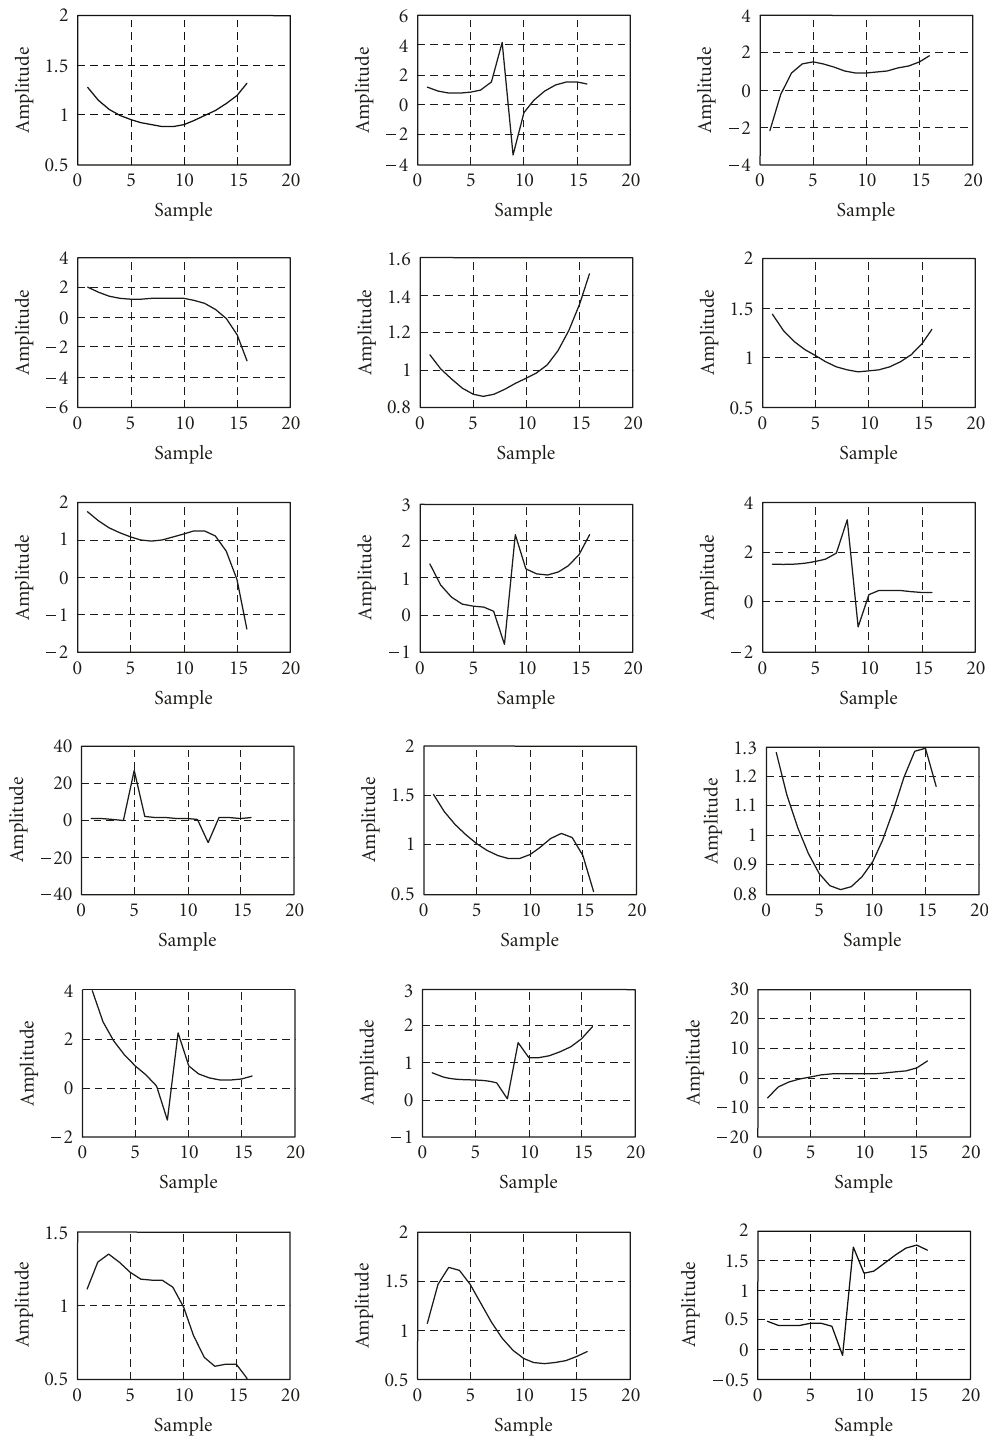
Figure 4: Some selected unique envelope vector in the predefined envelope set for L F =